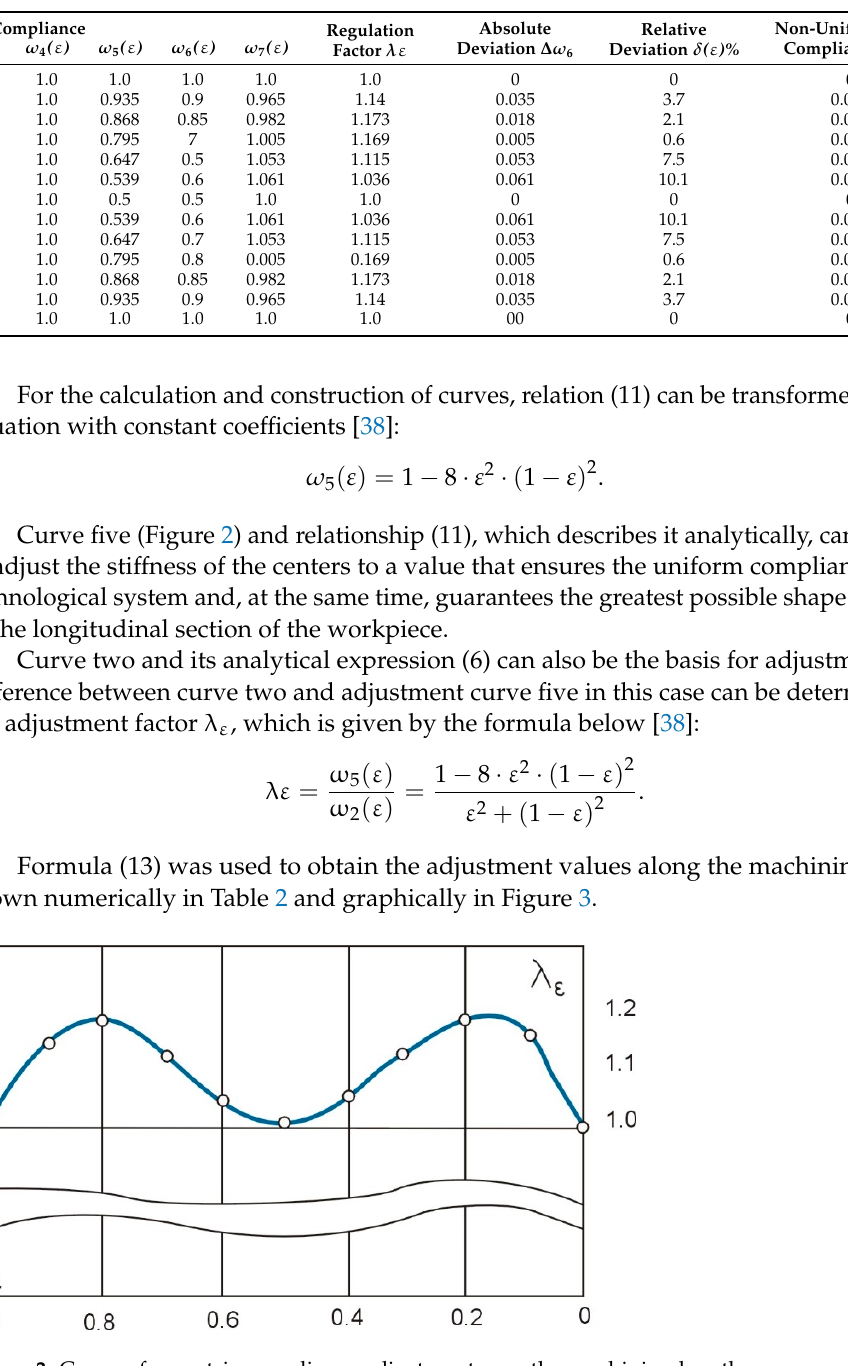
Table 2. Results of calculations of the relative compliance of the elastic technological system.